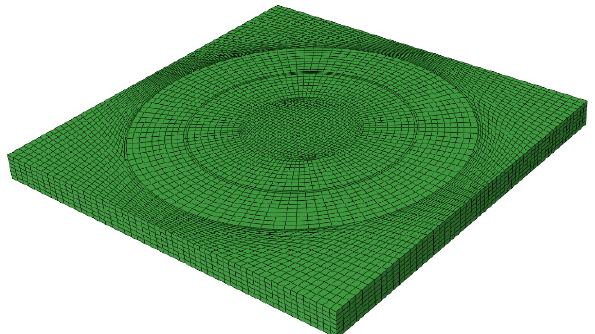
Figure 4. Finite element mesh of welded model.